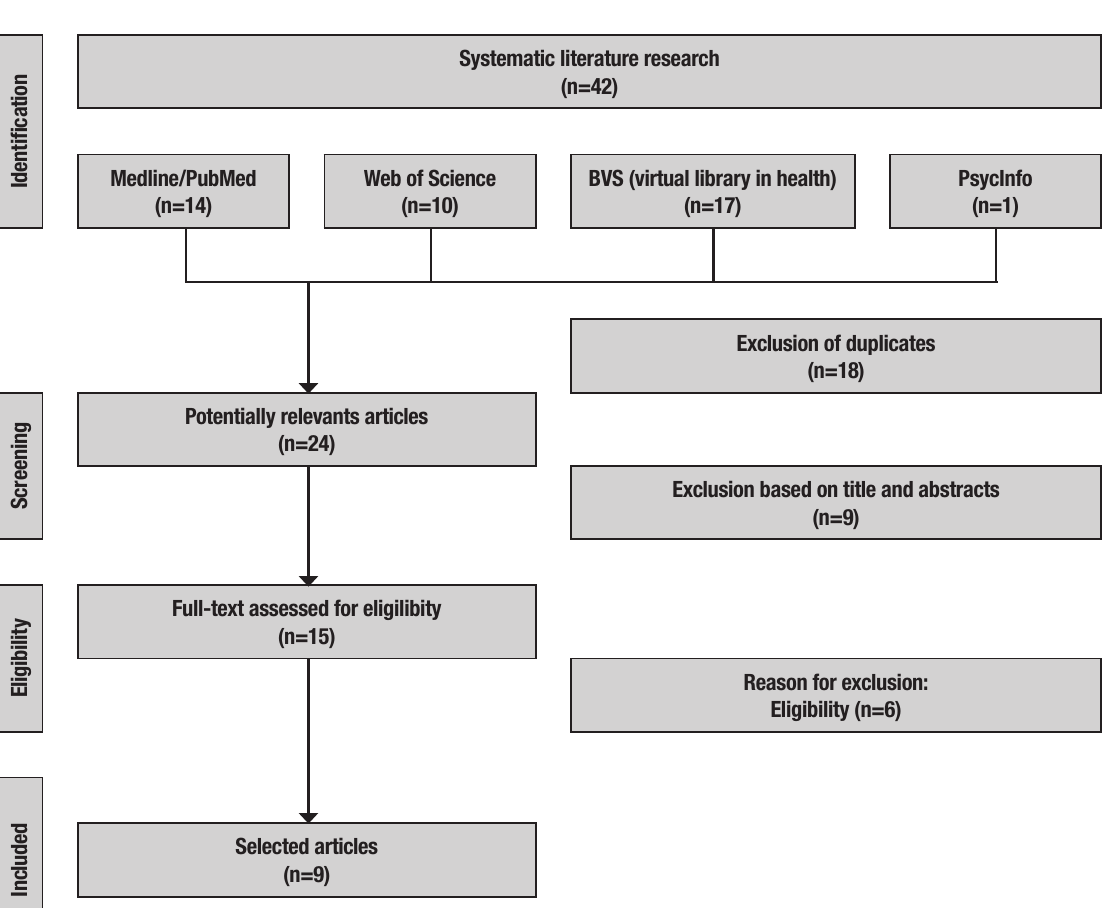
Figure 2. Flowchart of selected articles adapted from Moher et al.